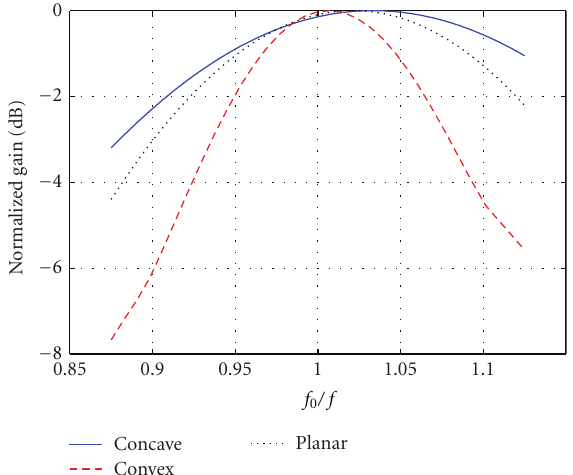
Figure 6: Normalized gain versus frequency for the reflectarray antennas.